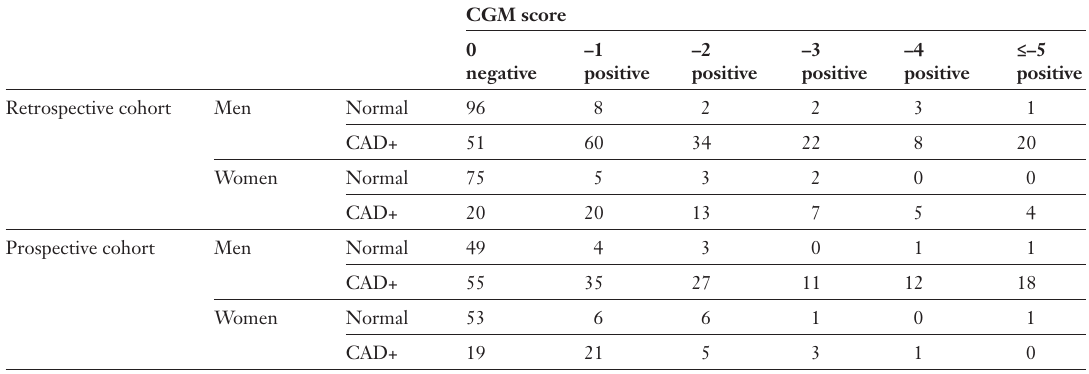
The gold standard used to assess CAD was coronary angiography.